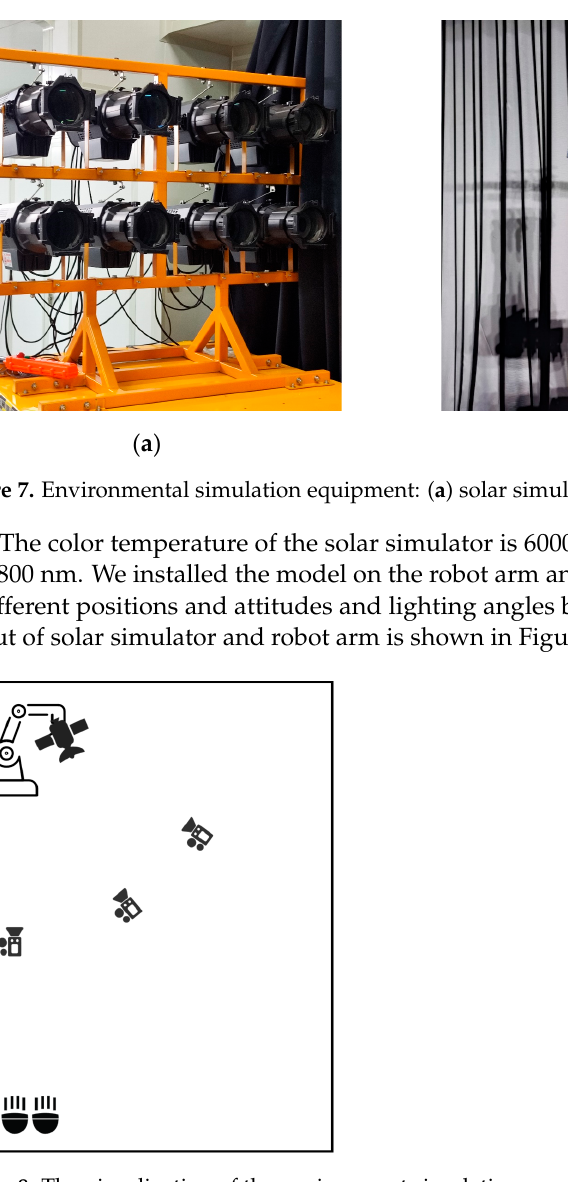
Figure 8. The visualization of the environment simulation room layout.